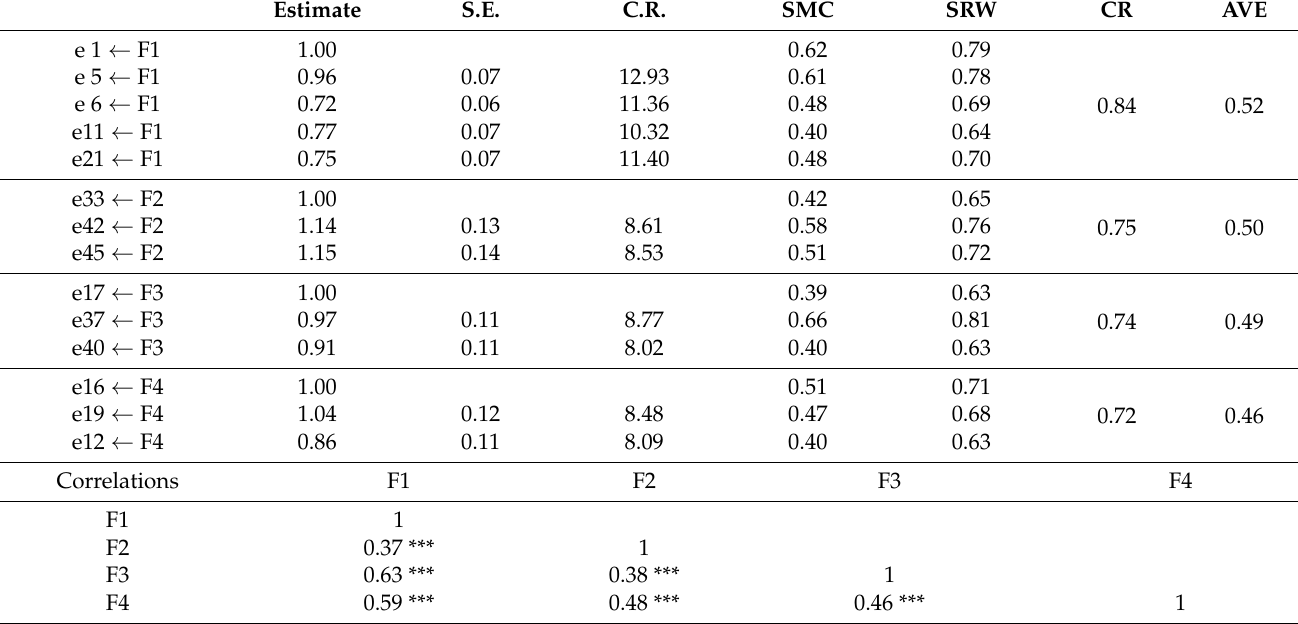
Table 3. Confirmatory analysis of